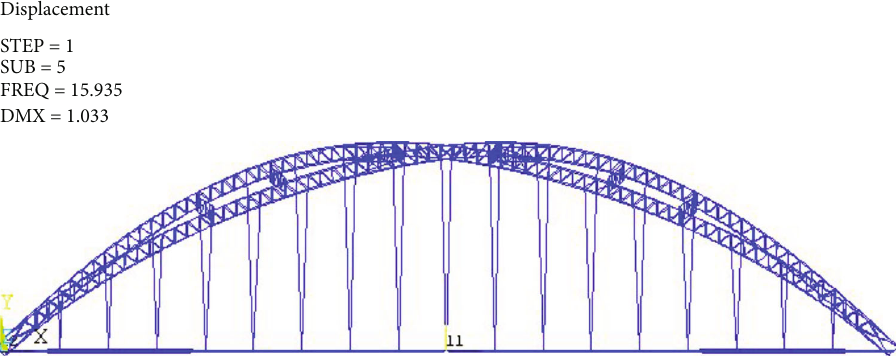
Figure 20: The fi fth order buckling mode of arch bridge under case